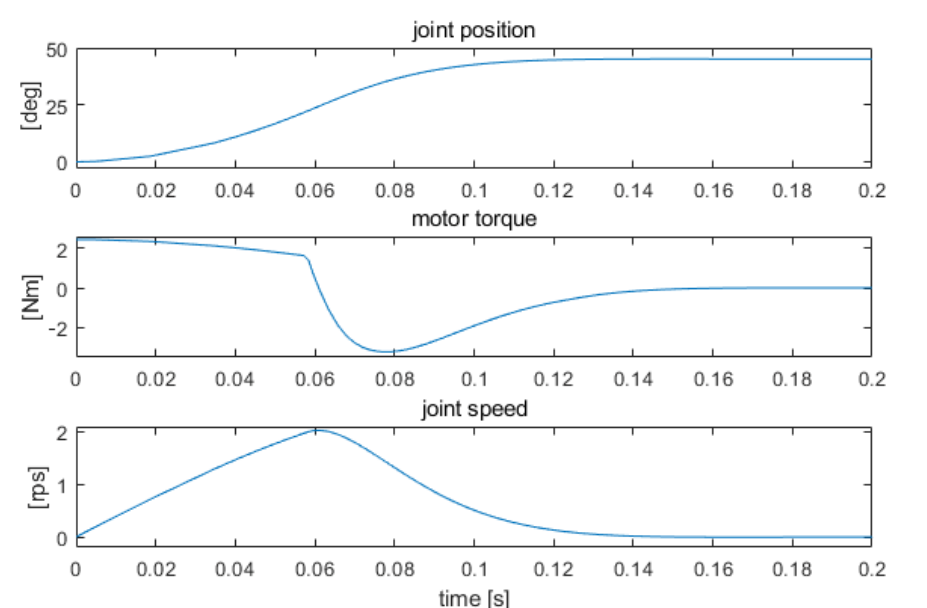
Figure 7. The course of a 45-degrees change in the position of the shoulder hinge.